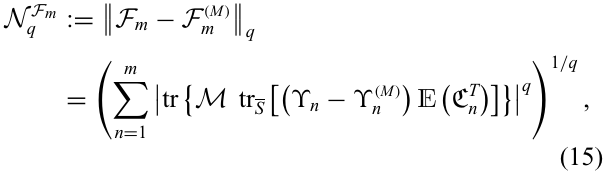
(σ) = acting as (cid:3) ( M ) n n